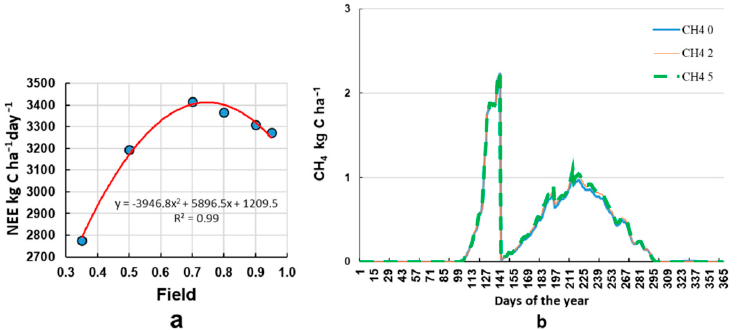
Figure 10. The modelled annual variations of the impact of “Field capacity” parameter on NEE ( a ) and daily variations of the impact of “Field capacity“ on NEE ( b ) based on the Great Vasyugan Mire in 2019.